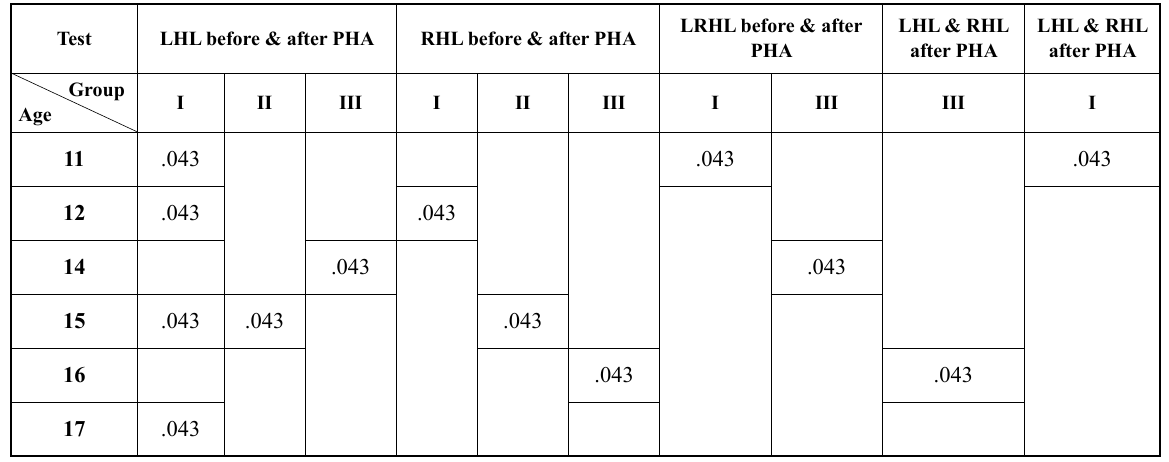
Table 1 . Statistical significance between reaction time tasks